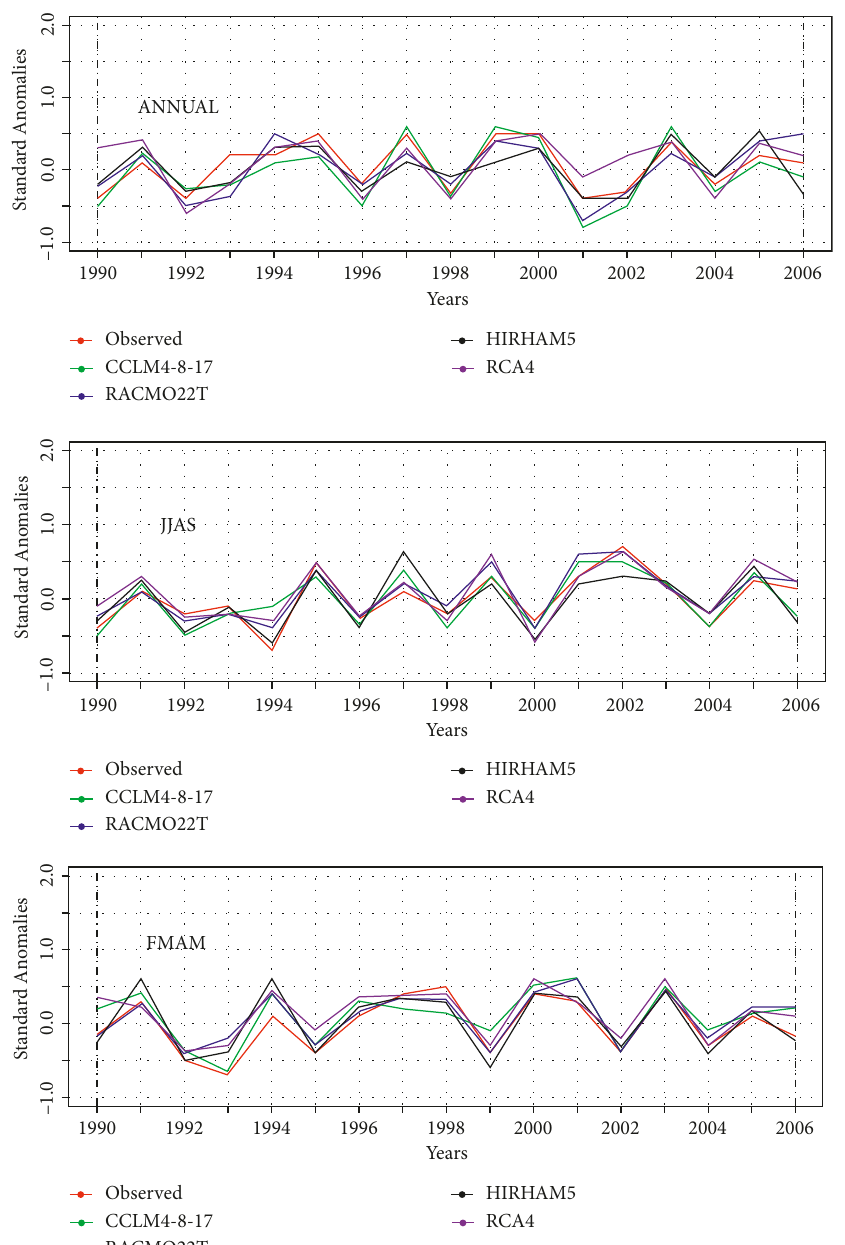
Figure 12: Interannual variability of Standardized minimum temperature Anomalies of Akaki